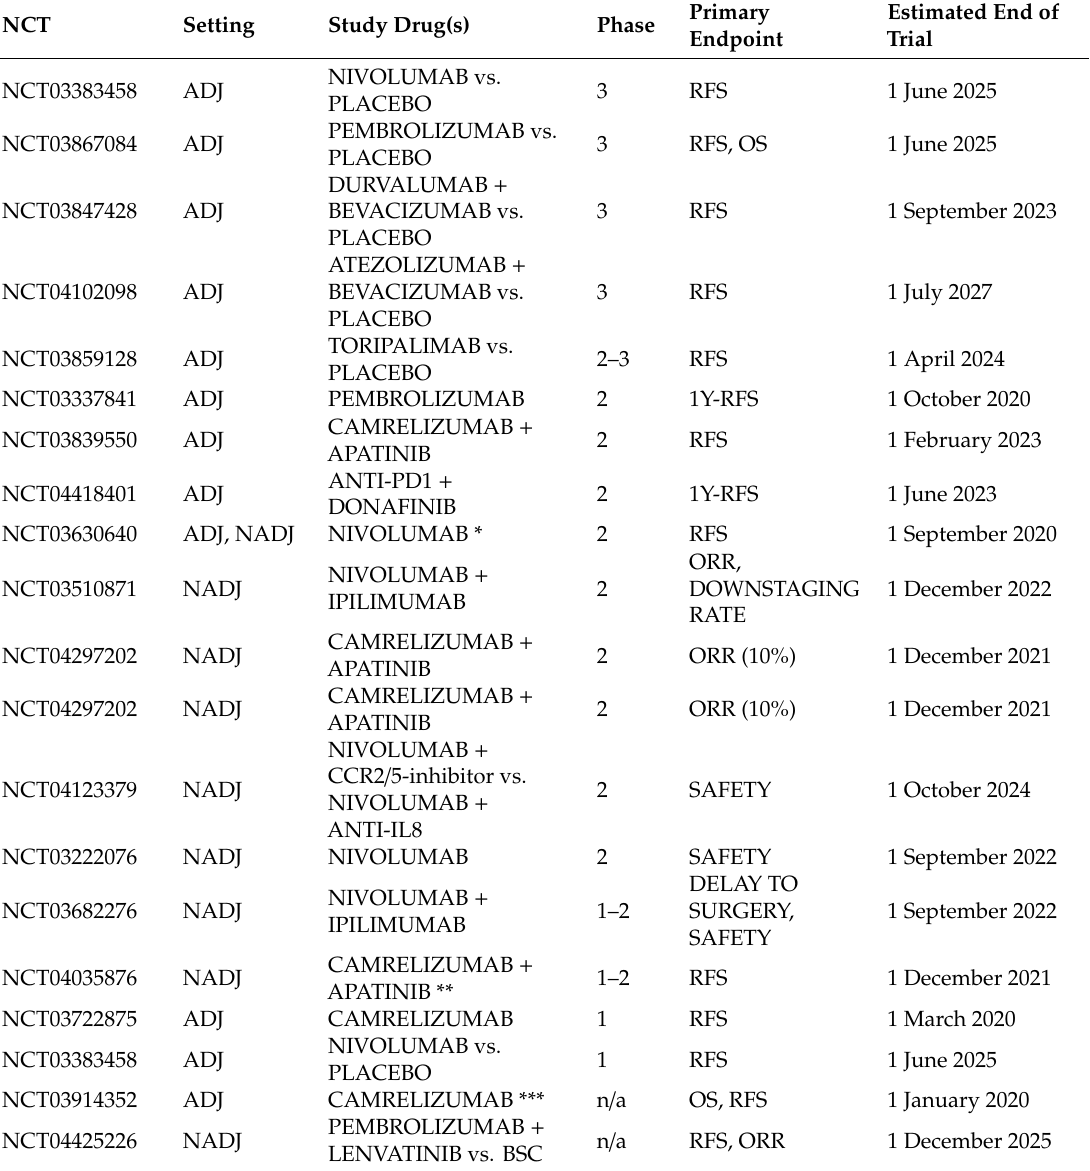
Table 4. Ongoing clinical trials exploring checkpoint inhibitors in the adjuvant and neoadjuvant setting.